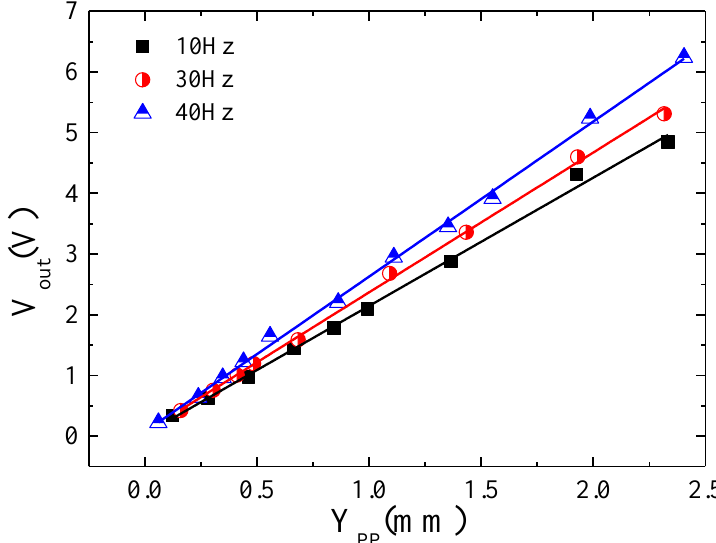
Figure 8. Peak to peak sensor output signal V out , versus peak to peak amplitude, Y pp , of vibration of the rectangular permanent magnet.